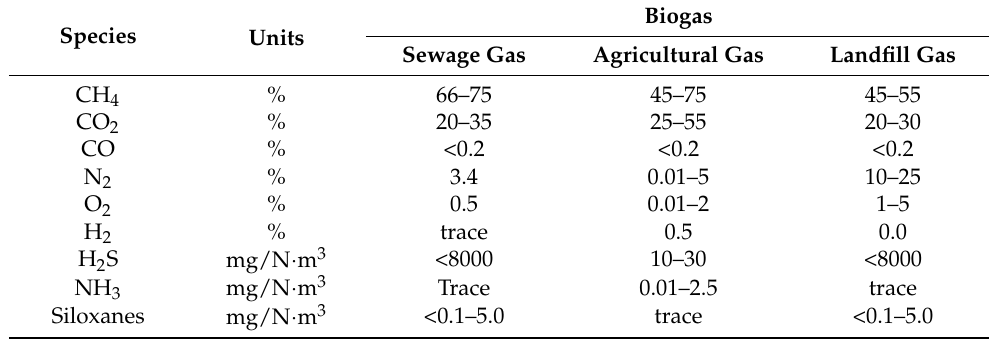
Table 8. Typical biogas